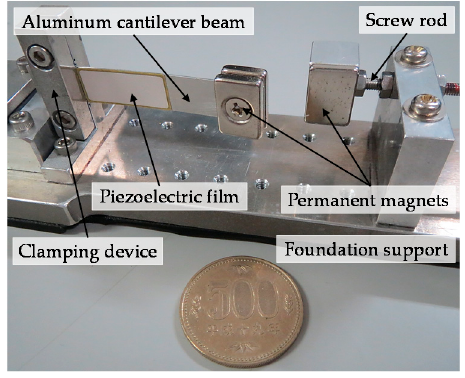
Figure 4. Diagram of the macro-scale energy harvester (The coin with diameter of 26.5 mm).